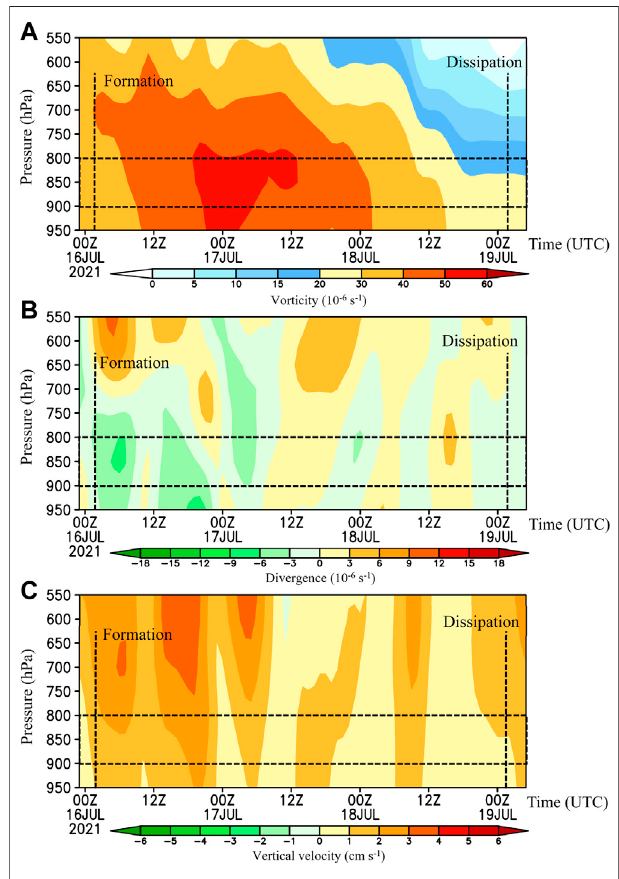
FIGURE 8 | Area-averaged (within the main body of the vortex) vorticity (A) , divergence (B) , and vertical velocity (C) , where the black dashed lines outline the central level of the vortex and its formation and dissipation